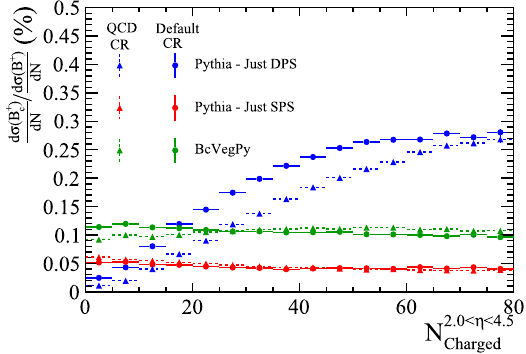
Fig. 24 Ratio of differential cross-section of B + c and B + hadrons as a function of (left) the number of parton interactions in a collision and (right)thenumberofchargedparticleswithinthepseudo-rapidityregion